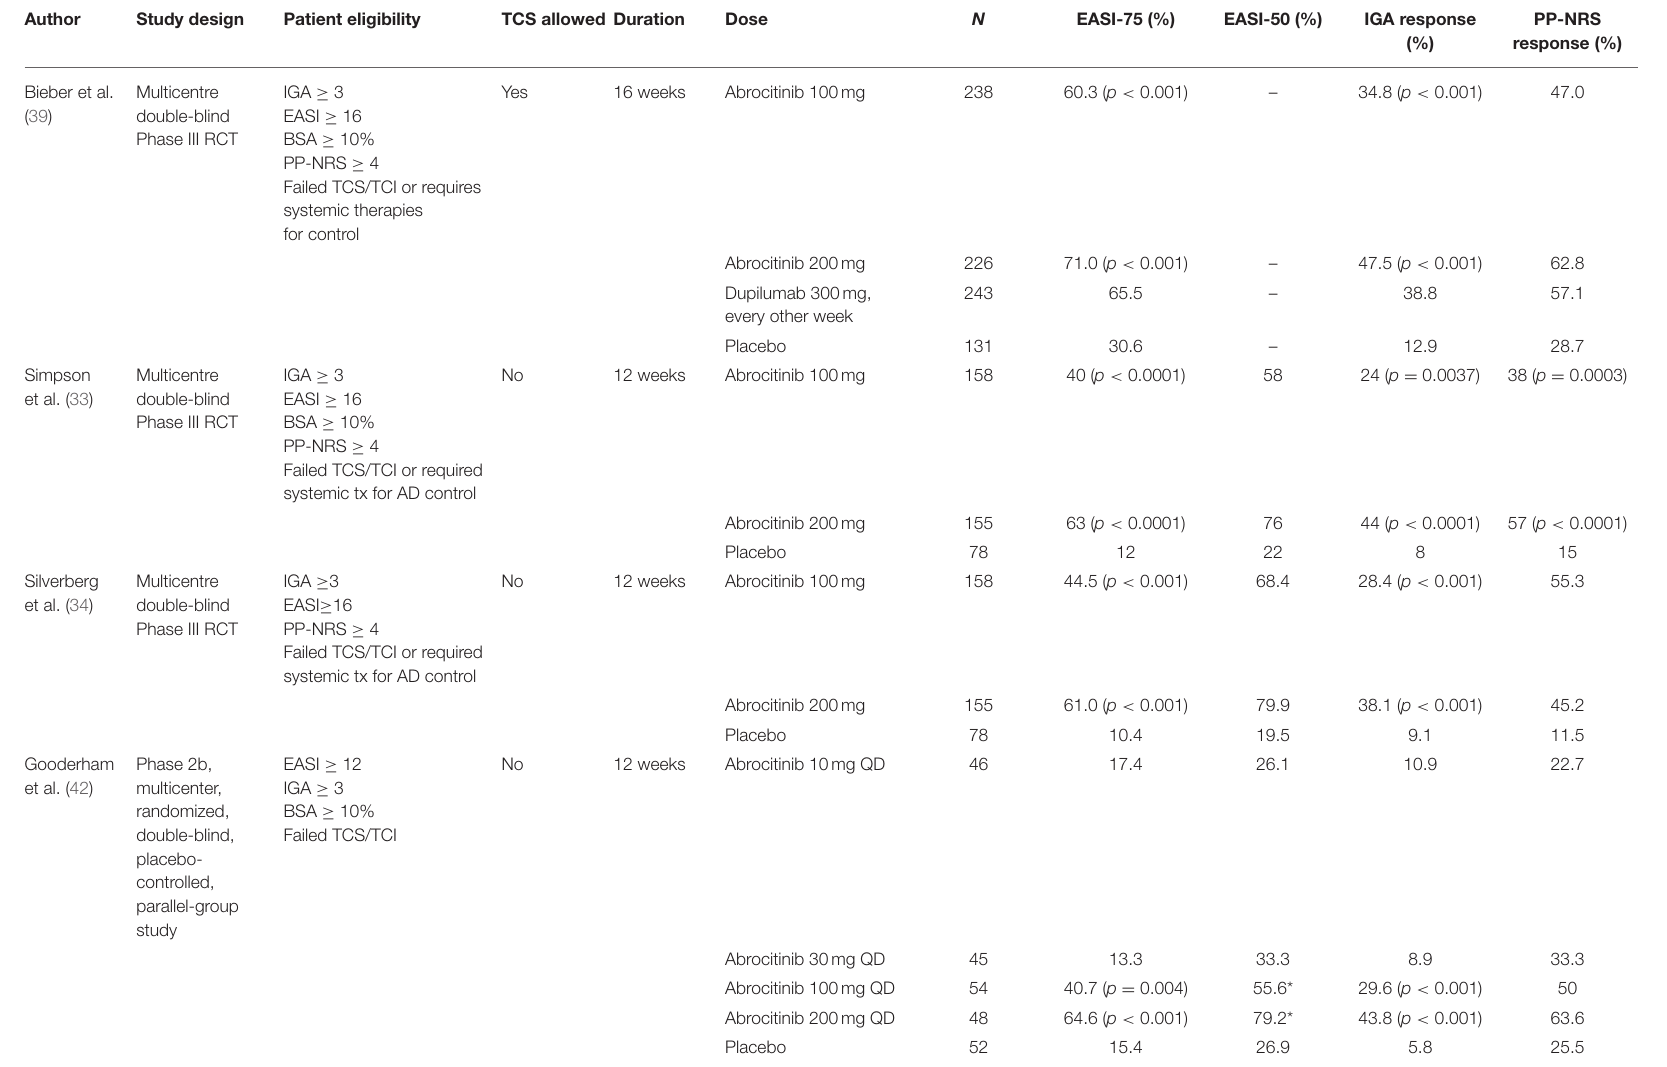
TABLE 1 | Summary of clinical efficacy of published oral JAK inhibitor